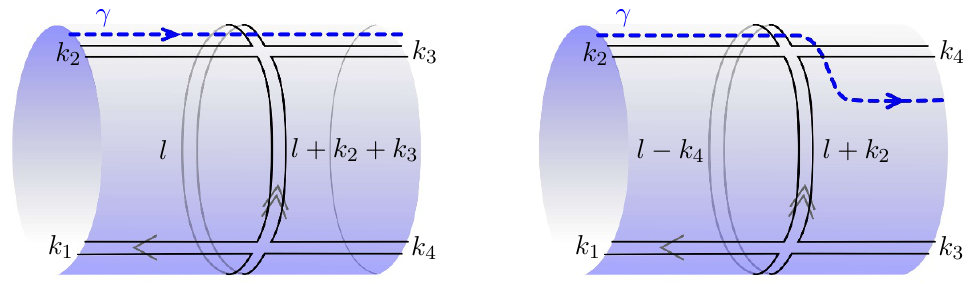
Figure 4 . The two one-loop Feynman diagrams that contribute to the four-point amplitude of f (cid:30) 1 ( k 1 ) ; (cid:30) 1 ( k 2 ) ; (cid:30) y ( k 3 ) ; (cid:30) y ( k 4 ) g 1 1